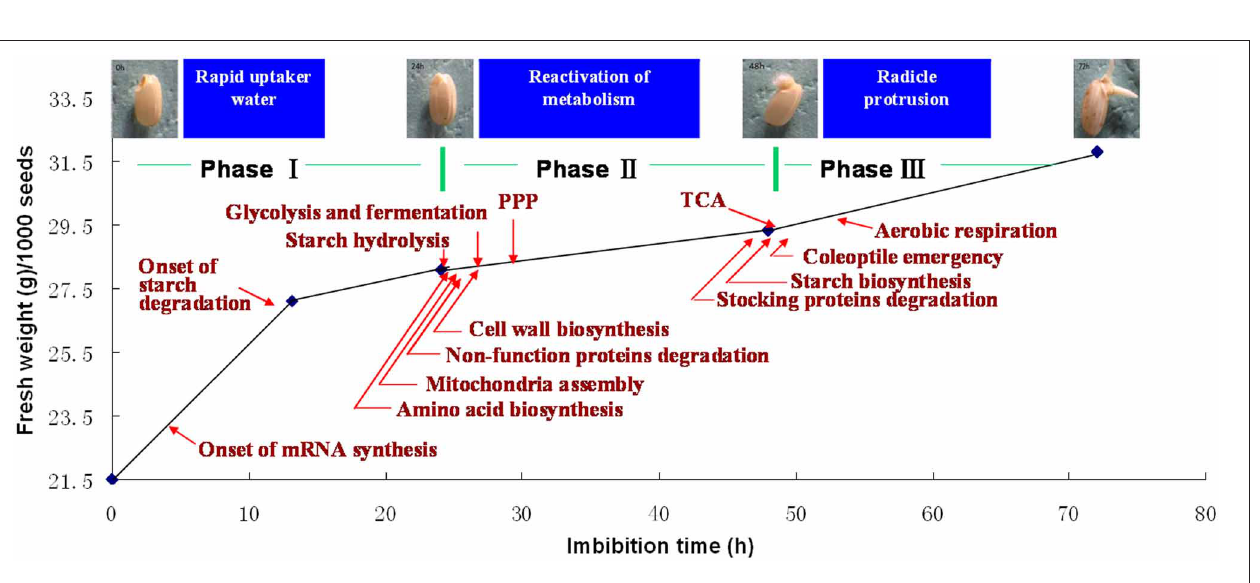
FIGURE 3 | Sequentially happened activities during rice seed germination. Upon imbibition, rice seed germination process could be divided into three phases (Yang et al., 2007). Phase I is the first rapid water-uptake period with the onset of mRNA biosynthesis (Howell et al., 2009), phase II is the most important stage for metabolism reactivation,